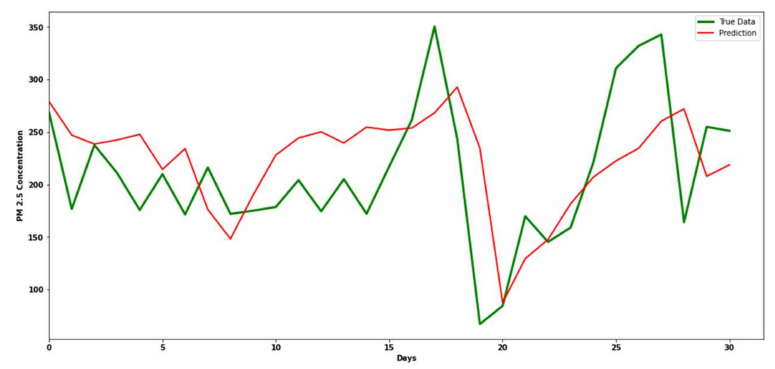
Figure 9. Forecasting for the next month for Lahore using the LSTM model.